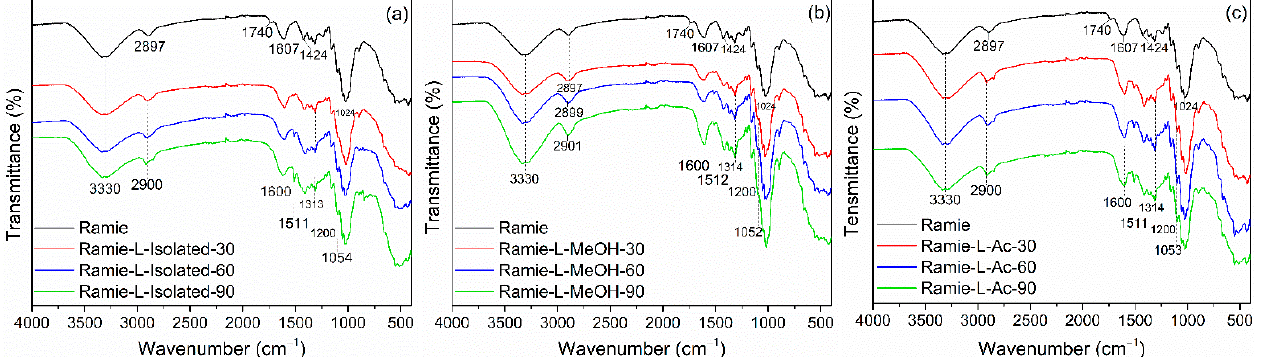
Figure 11. FTIR Spectra of impregnated ramie fibers: ( a ) Ramie L ‐ Isolated, ( b ) Ramie L ‐ MeOH, and ( c ) Ramie L ‐ Ac. The functional groups of ramie fiber after impregnation were also observed using FTIR. A peak similar to the original ramie at a wavenumber of 3330 cm − 1 indicated O ‐ H